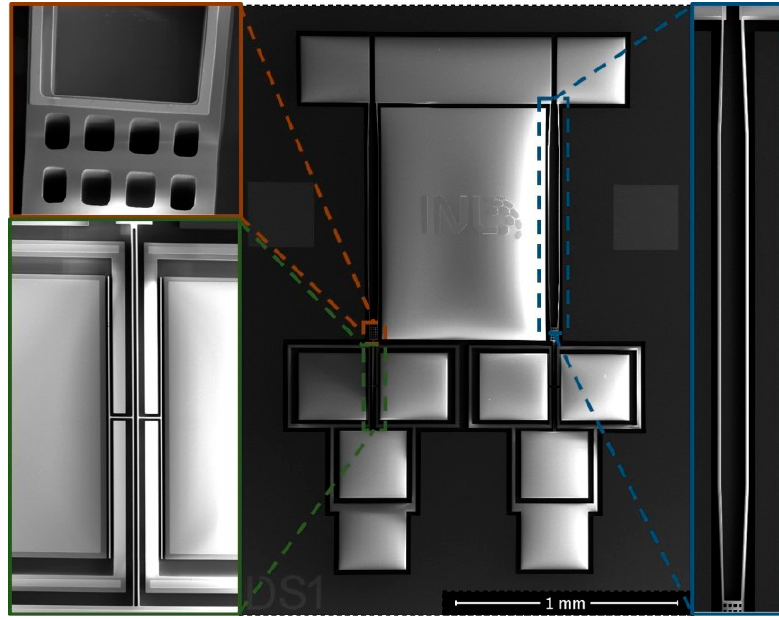
Figure 2. SEM image of the fabricated